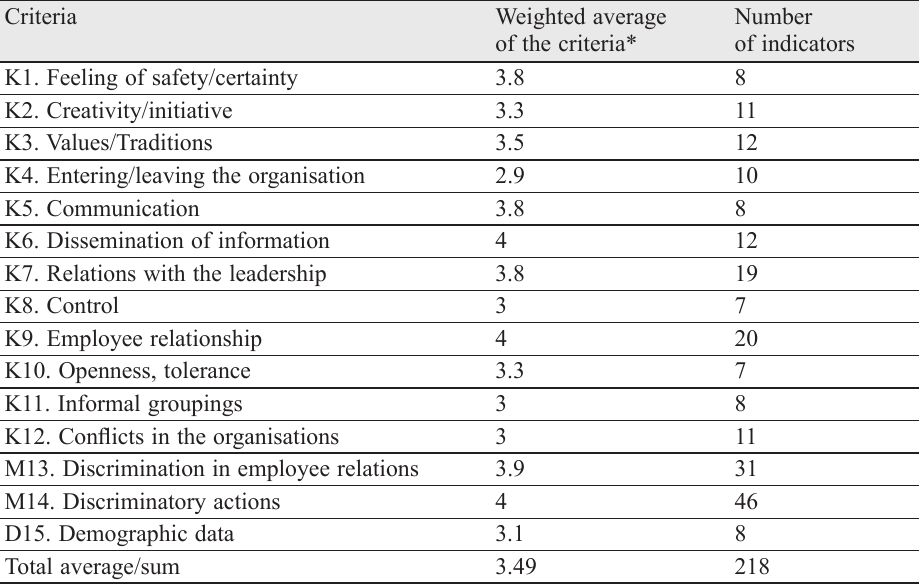
Table 2. Weighted average of the criteria presented for assessment and the number of indicators Criteria Weighted average of the